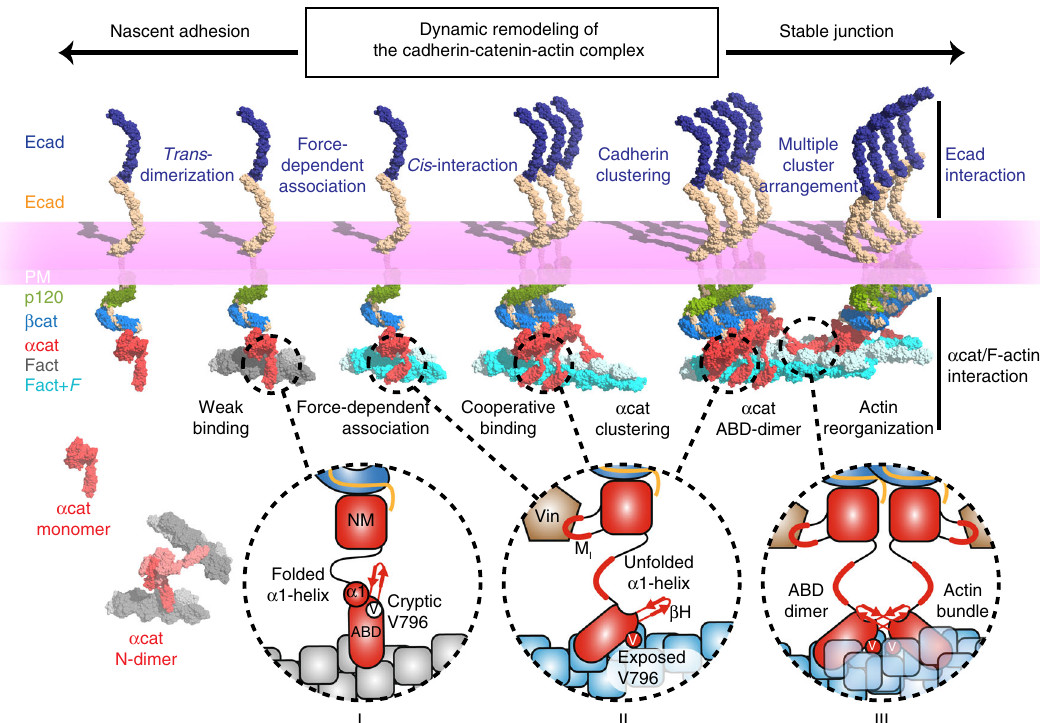
Fig. 7 Dynamic remodeling of the cadherin-catenin-actin complex. A model of α -catenin-dependent cadherin-actin linkage, cadherin clustering and F-actin bundling involved in the regulation of cadherin-mediated cell-cell adhesion facilitating nascent and stable junctions. The ABD of α -catenin bound to the cadherin- β -catenin complex is in an attenuated state with the folded α 1-helix and cryptic V796 to form weak interactions with F-actin (I). α -catenin dissociated from β -catenin can exist as a monomer and an N-terminally linked homodimer (N-Dimer). When the cadherin-catenin complex encounters F- actin under force (Fact + F ), α cat-ABD exposes V796 on the surface while the α 1-helix unfolds to form a catch bond with F-actin (II). The force propagates through α -catenin to unfold the M I region, which facilitates the recruitment of vinculin (Vin) to AJs. Strong F-actin binding promotes cooperative binding of ABD. As α -catenin clusters together on F-actin, ABD dimerization between two ABD-coated actin fi laments promotes actin bundling and lateral clustering of cadherin-catenin complexes at AJs